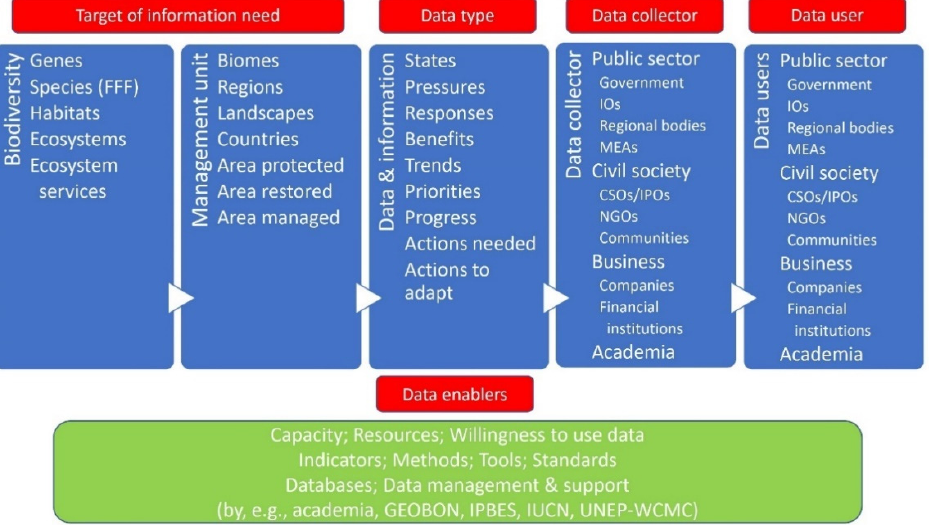
Figure 1. A summary of the types of biodiversity data users and their data needs, and the enabling factors (data enablers) that facilitate data flow. MEA = multilateral environment agreements; IO = international organisation; CSO = civil society organisation. IPO = indigenous peoples organisation.